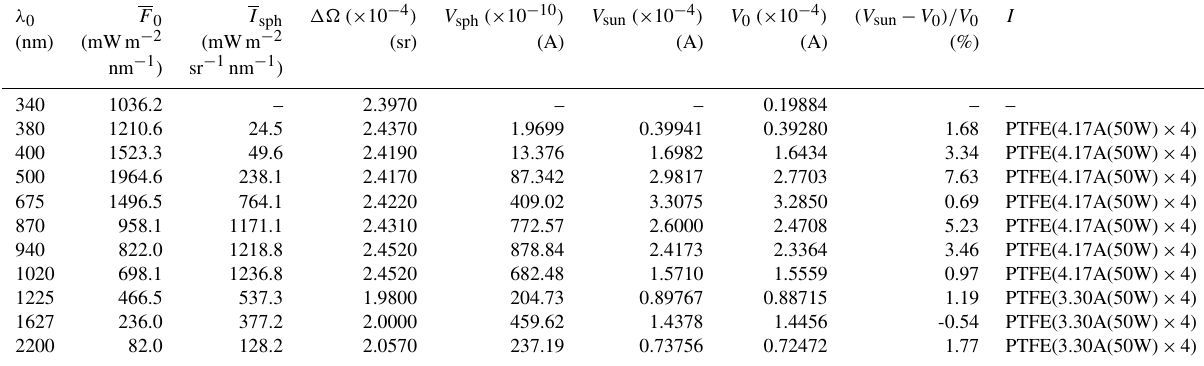
Table 5. Calibration constants for POM-02 determined by using the calibrated integrating sphere measurement. λ